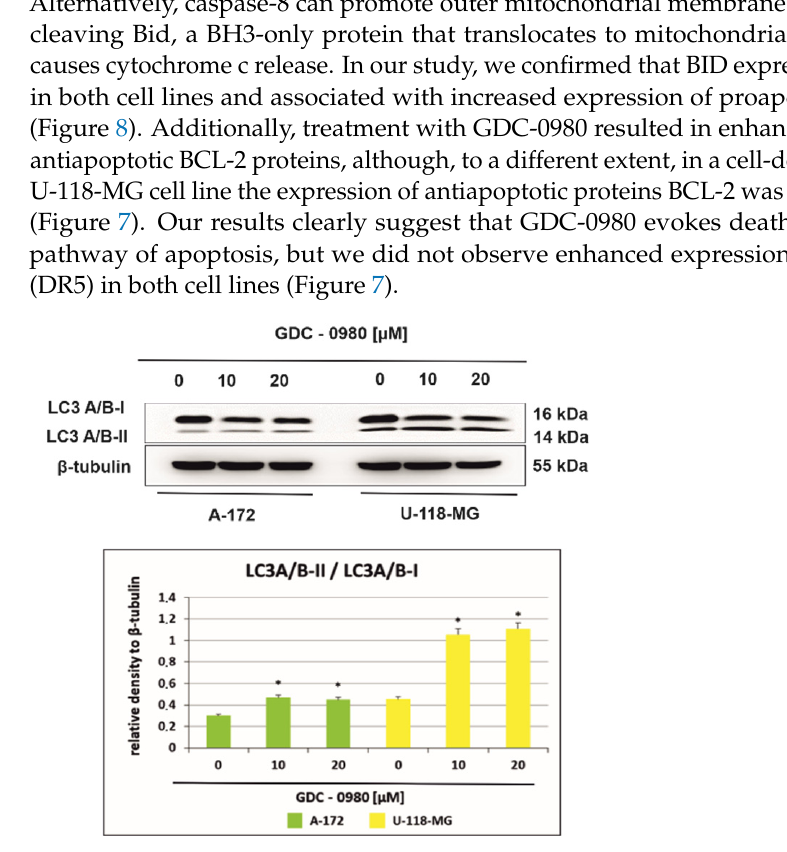
Figure 8. Western blot analysis demonstrates the effect of 48 h GDC-0980 treatment on the expression of autophagy marker Light Chain 3 (LC3A/B-I and LC3A/B-II) expression in A-172 and U-118 MG glioblastoma cells, using β -tubulin as a protein-loading control. The representative bands of the LC3A/B-I and LC3A/B-II to β -tubulin are illustrated. Samples containing 20 µ g of protein were submitted to electrophoresis and immunoblotting. Data are presented as the means ± SEM. * p <